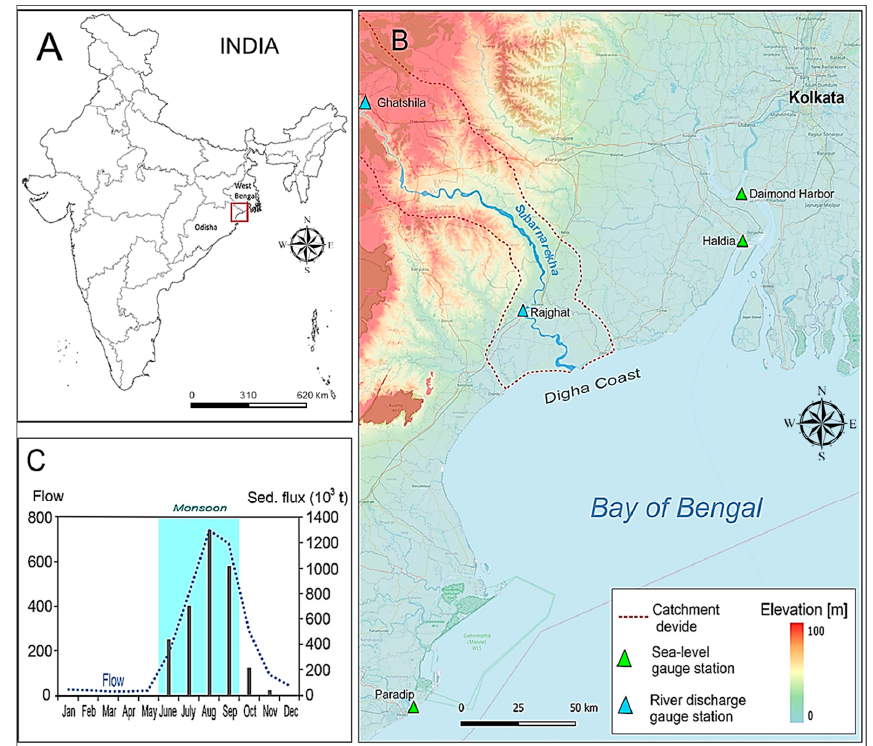
Figure 1. Location of the study area on the map of the Indian states (West Bengal, Odisha) ( A ), on the physical map with the location of measurement stations ( B ) and monthly mean water discharge and sediment fluxes for station Ghatshila in the period 1970–2015 ( C